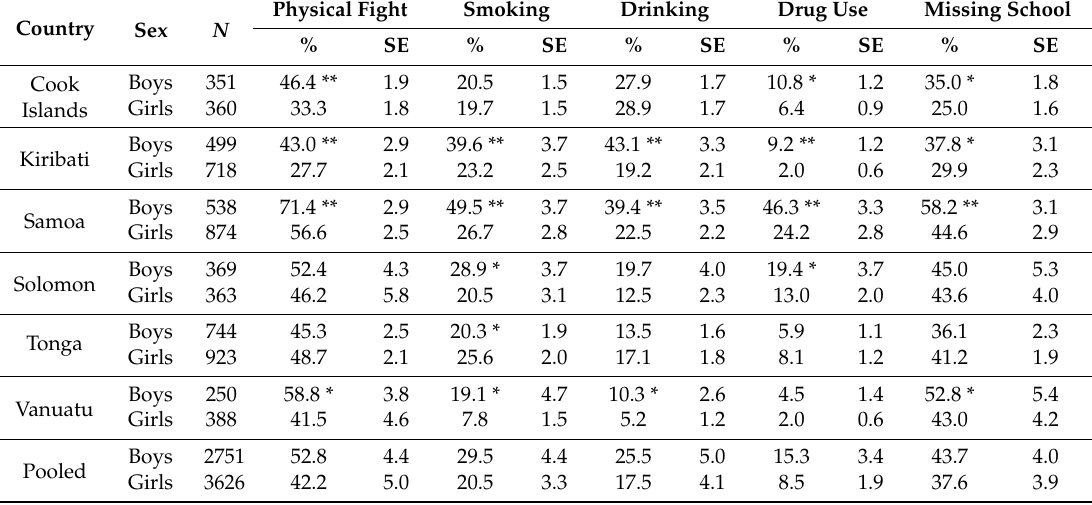
Table 2. Prevalence of physical fighting, smoking, drinking, drug use, and missing school in young adolescents in 6 Western Pacific